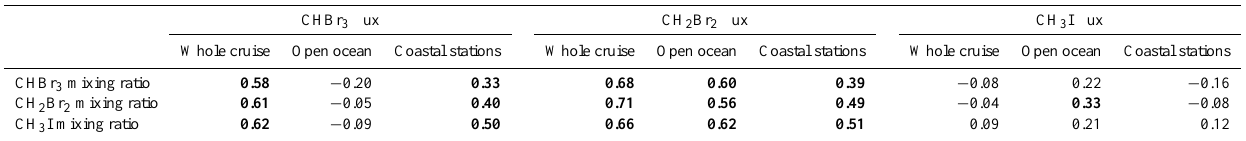
Table 5. Correlation coefficients of bromoform (CHBr 3 ), dibromomethane (CH 2 Br 2 ) and methyl iodide (CH 3 I) fluxes with according mixing ratios. Whole cruise (leg 2 and 3) includes n = 109 samples, open ocean (leg 2 except stations 3–6 and leg 3) includes n = 37 samples and coastal stations (stations 3–6) include n = 70 samples. Bold coefficients have a p value of less than